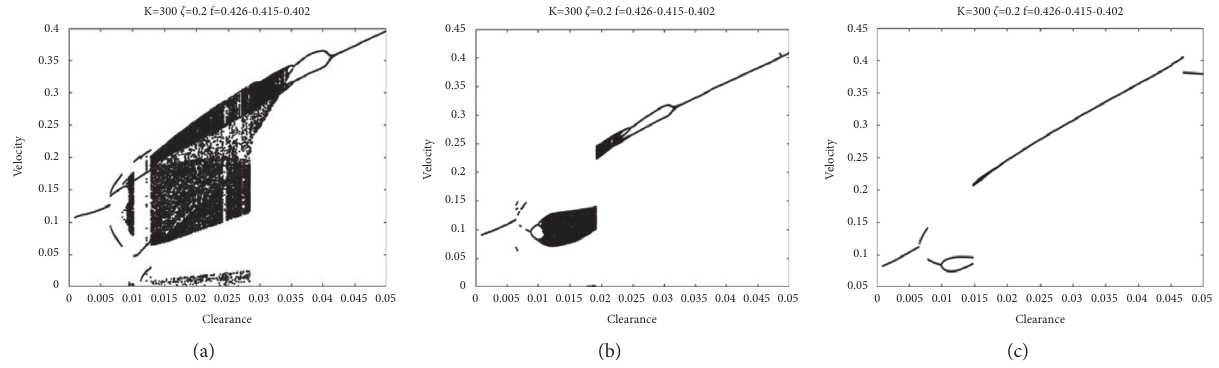
Figure 16: The effect of hinge clearance. (a) f � 0 . 402 Hz, (b) f � 0 . 415Hz, and (c) f � 0 . 426 Hz.